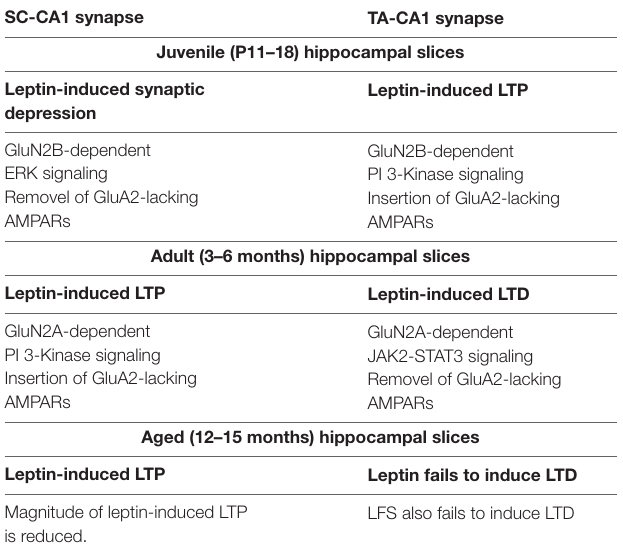
Summary table illustrating the bi-directional effects of the hormone leptin at hippocampal Schaffer-collateral (SC)-CA1 and temporoammonic